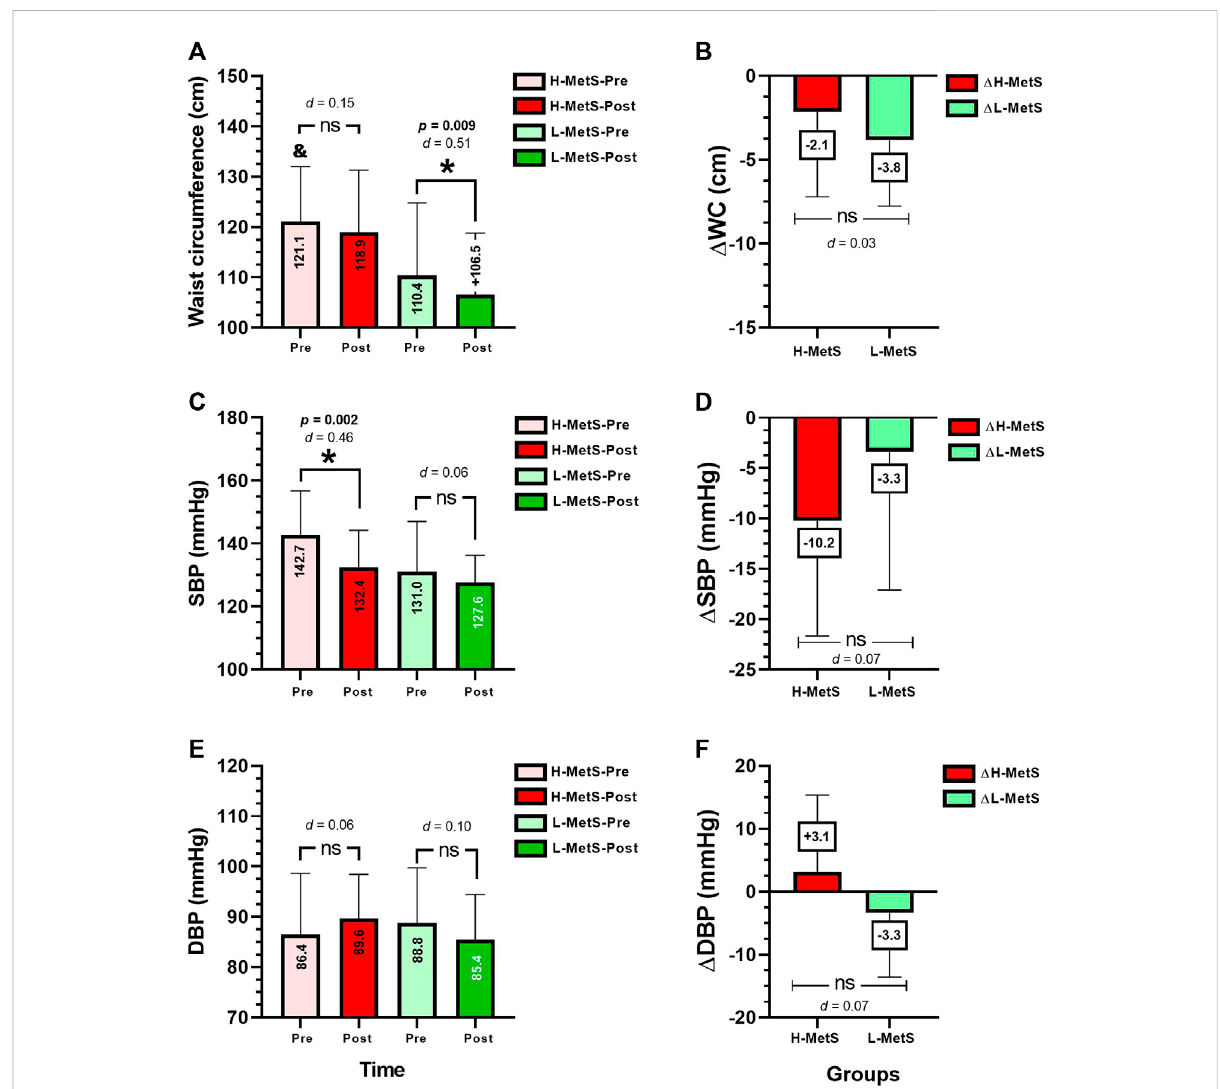
FIGURE 1 Metabolic syndrome outcomes before and after (A,C,E) , and delta changes (B,D,F) between two groups of a different number of risk factors for metabolic syndrome. Groups are described as H-MetS-Pre, high number of metabolic syndrome risk factors groups at pre-test; H-MetS-Post, high number of metabolic syndrome risk factors groups at post-test; L-MetS-Pre, low number of metabolic syndrome risk factors group at pre test; L-MetS-Post, low number of metabolic syndrome risk factors group at post test. Outcomes are described as; WC, waist circumference; SBP, systolic blood pressure; DBP, diastolic blood pressure. (&) Denotes the signi fi cantly different versus baseline L-MetS group at p < 0.05. ( d ) Denotes Cohen d effect size at p < 0.05. (*) Denotes the signi fi cant differences between the H-MetS vs. L-MetS group at p < 0.05. (ns) Denotes no signi fi cant differences between